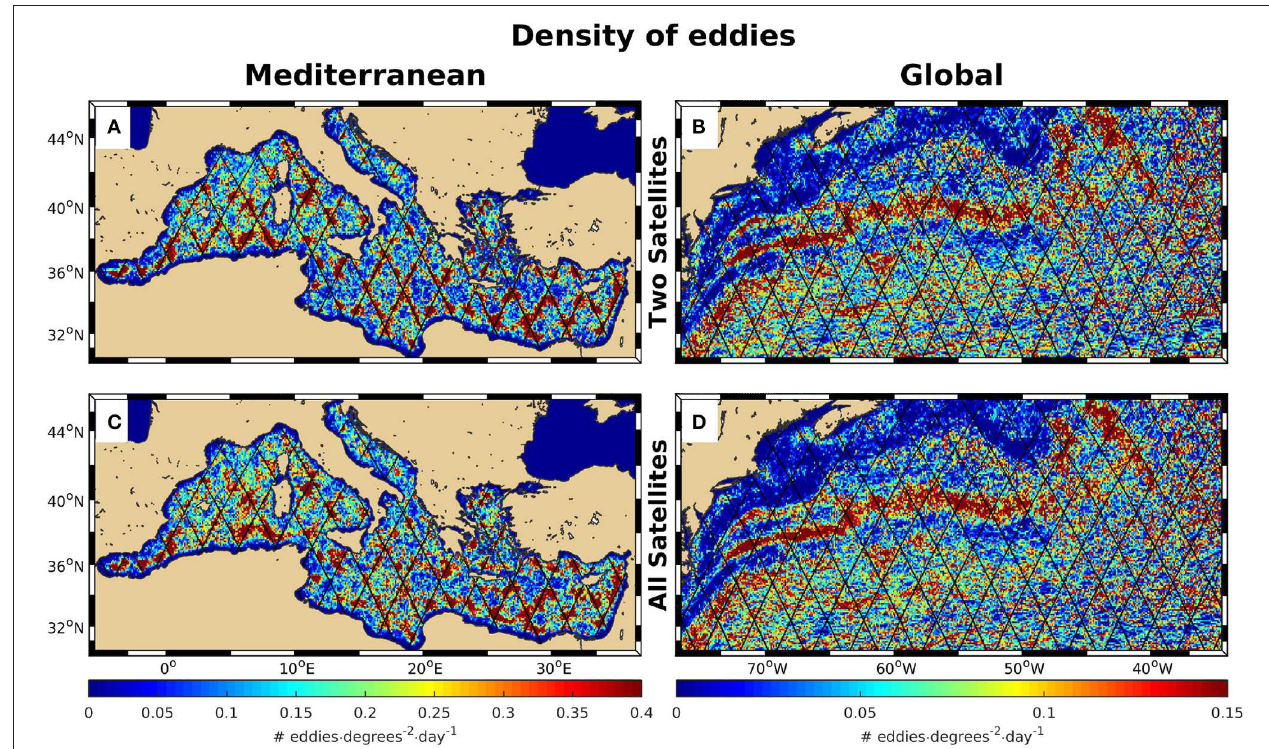
FIGURE 1 | Eddy density maps computed on a 0.1 ◦ grid for the Mediterranean Sea (A,C) and the North Atlantic ocean (B,D) . The maps for the Mediterranean Sea (North Atlantic ocean) are computed from the two versions of the regional (global) SLA product delivered by Copernicus: the two satellites version (A,B) and the all satellites version (C,D) . Black lines indicate the position of the Topex/Poseidon satellite ground tracks. The area shown in the maps have the same size for the Mediterranean and global SLA